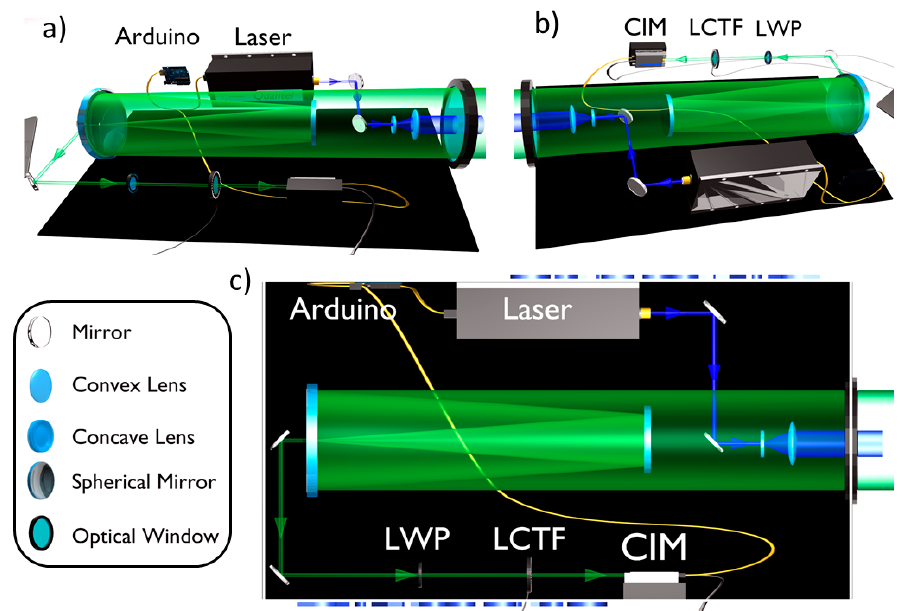
Figure 1. Hyperspectral LIDAR fluorosensor with its components. The excitation light emitted by the laser is sent through a Galilean beam expander to the target. The LIF signal is collected by a Cassegrain collection optics configuration and detected by a LCTF coupled with a CIM unit.